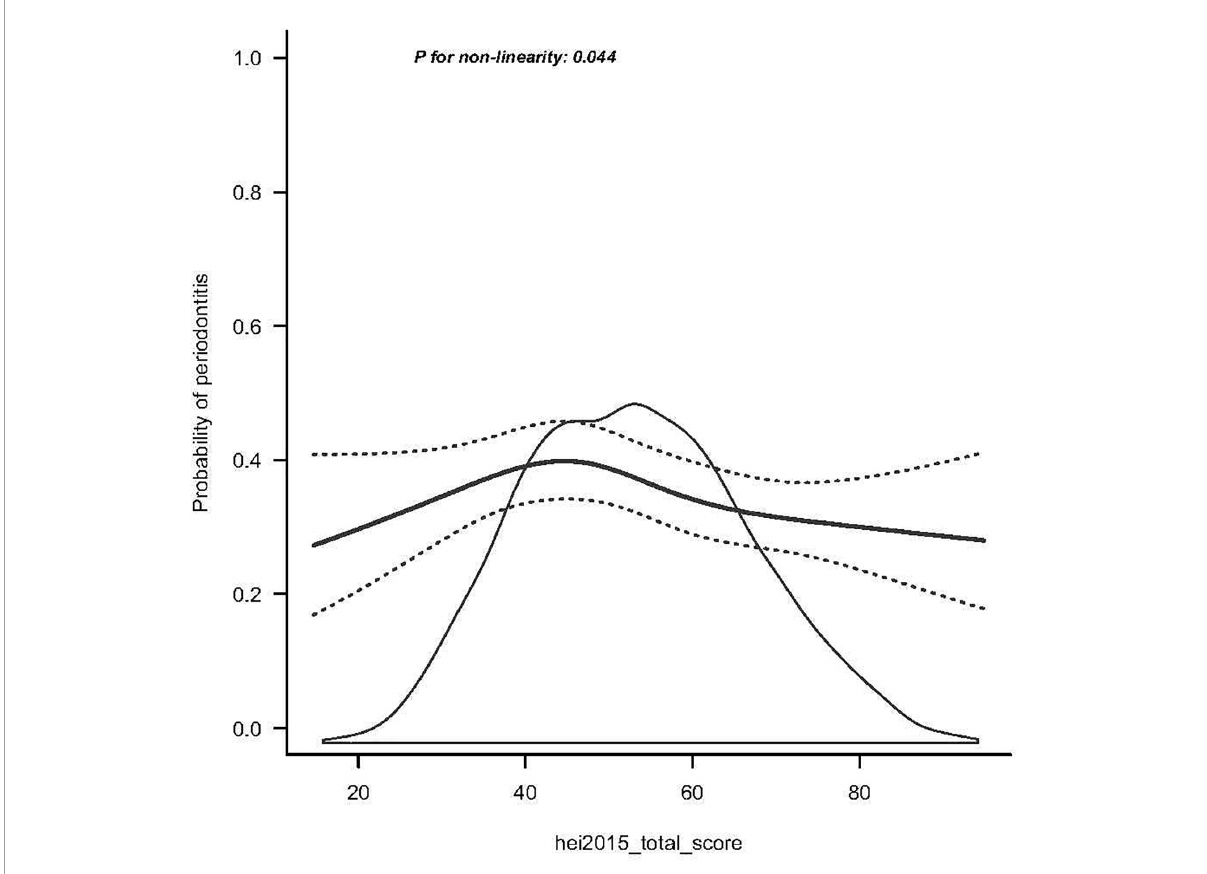
FIGURE2 Smooth curve fitting of periodontitis and HEI-2015. The black solid line represents the average trend; black dotted lines correspond to the 95% credible